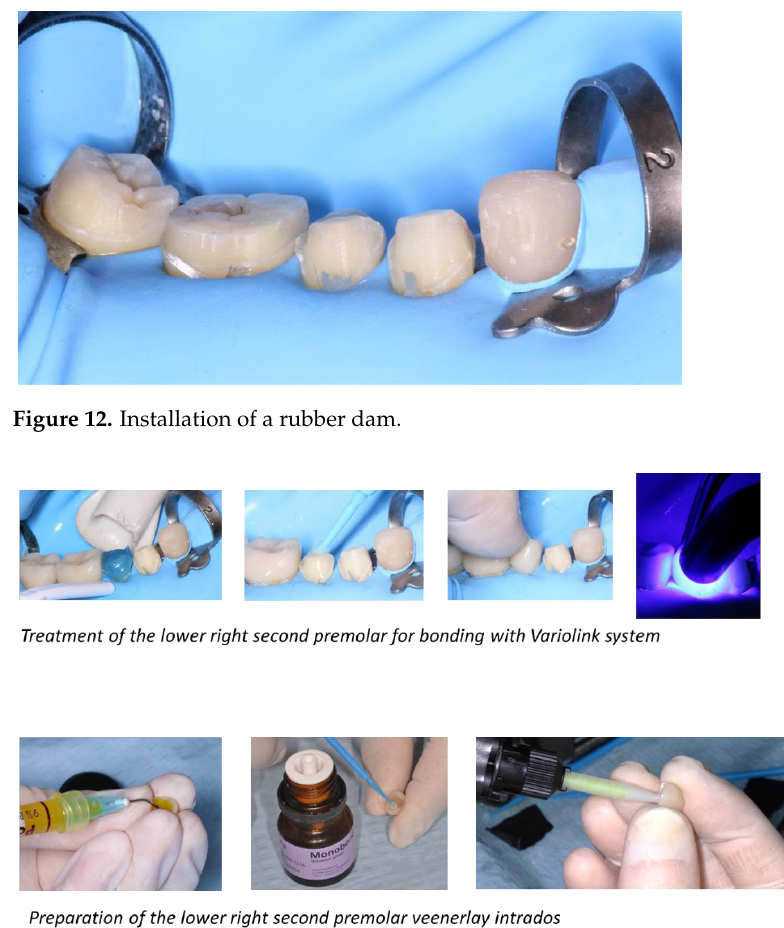
Figure 13. Bonding protocol for the lower right second premolar with Variolink system.